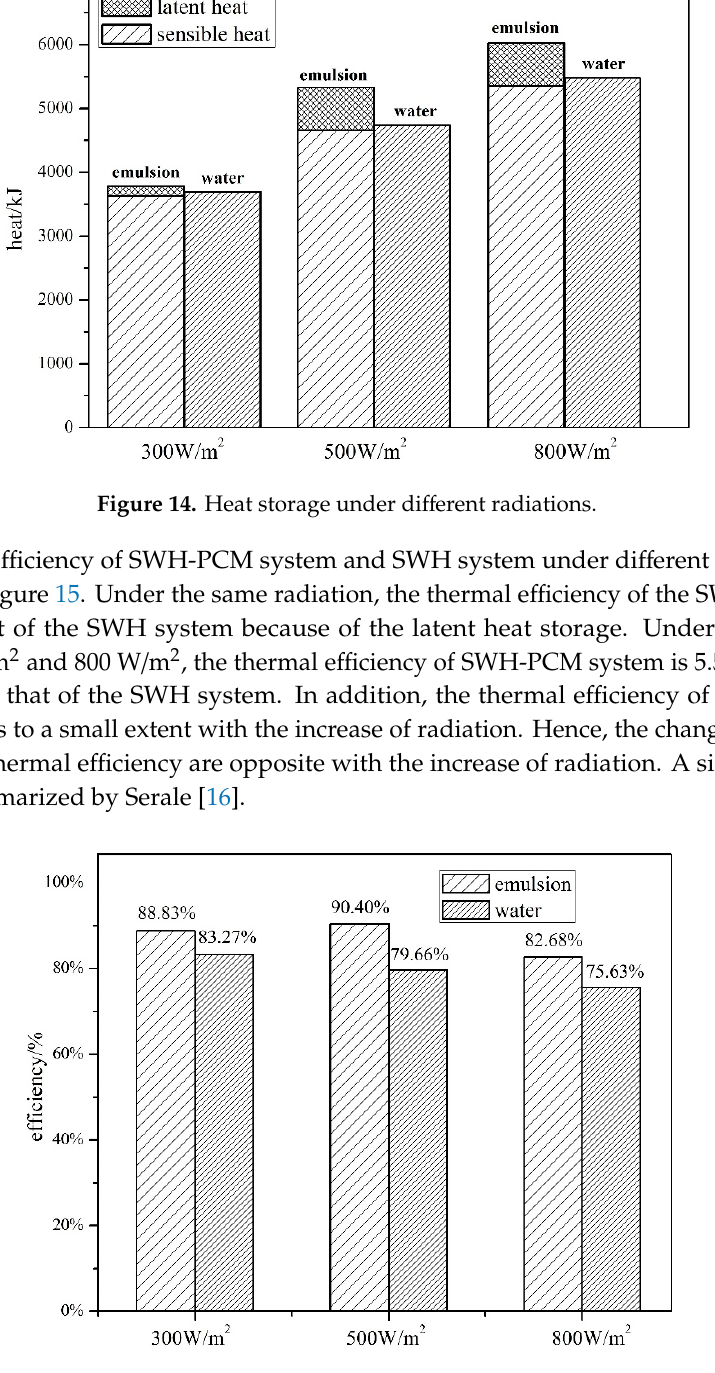
Figure 15. Thermal e ffi ciency under di ff erent radiations.